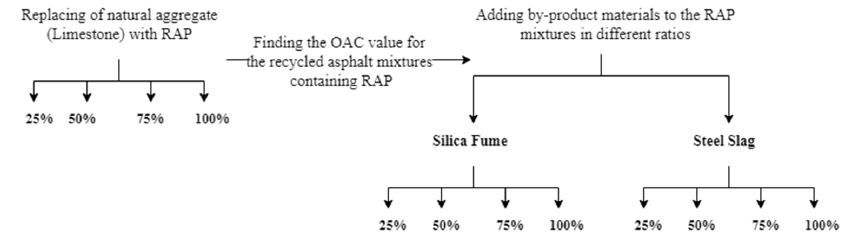
Figure 1. Experimental work flowchart. Table 1. Typical properties of the aggregate material used for the control mix.